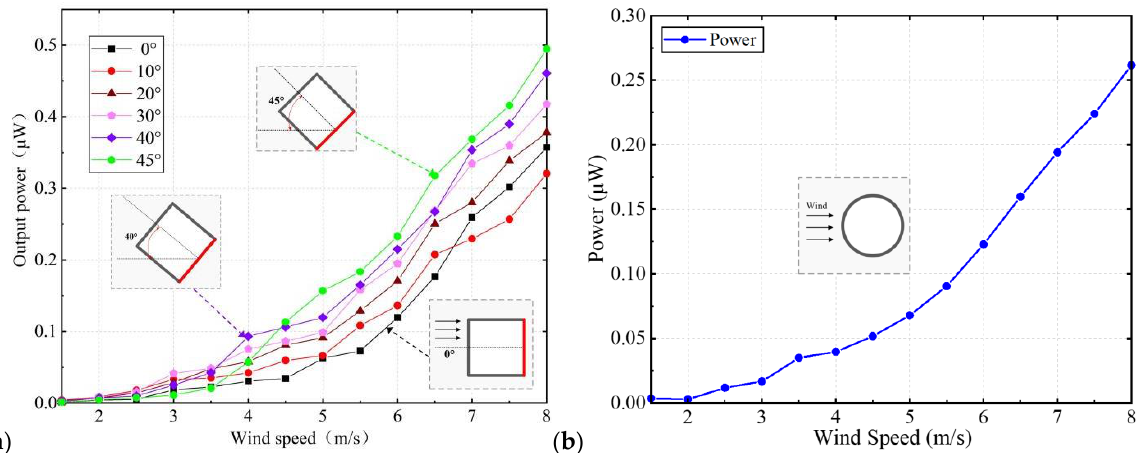
Figure 5. ( a ) The output power of the harvester with square-section cylinder responses to various wind velocities and wind attack angle θ. ( b ) The power output of the harvester with cylinder versus wind velocity.